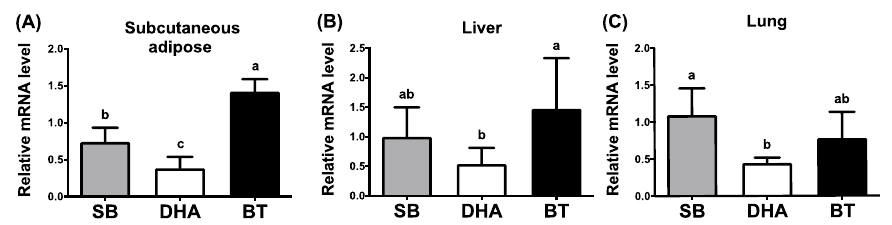
Figure 2. Effects of dietary fats on the expression of TN mRNA in various tissues of weaned piglets. Gene expression of tetranectin (TN/ CLEC3B ) in the ( A ) subcutaneous adipose, ( B ) liver and ( C ) lung tissues of weaned pigs, supplemented with 2% soybean oil (SB), docosahexaenoic acid oil (DHA) or beef tallow (BT) for 30 days, was determined by qPCR and normalized to β -actin in the same sample. Data were expressed as mean ± SD ( n = 6–8 for each group) and were analyzed by one-way analysis of variance (ANOVA). Different superscript letters (a, b, c) indicate significant difference ( p ≤ 0.05) determined by Tukey’s multiple comparison test.